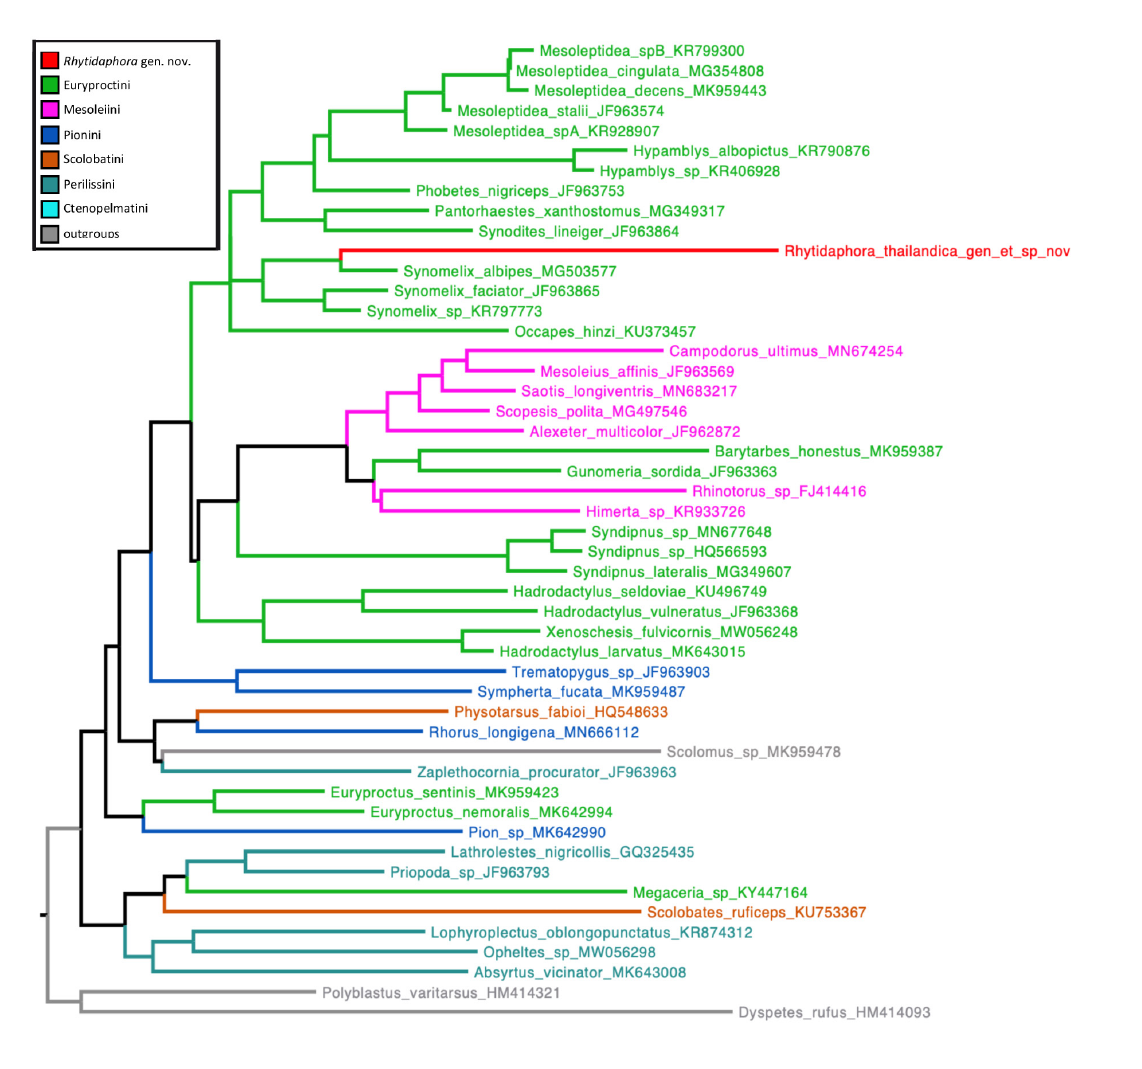
Fig. 3. Maximum likelihood tree based on a 658 base pair segment near the 5′, terminus of the CO1 gene. This tree includes the new genus plus at least one representative of each genus of Ctenopelmatinae Förster, 1869 with a DNA barcode, plus two tryphonines as